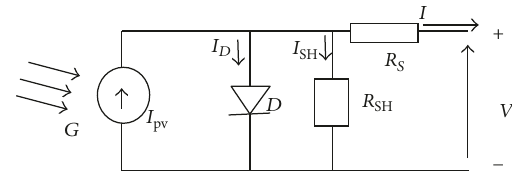
Figure 3: Single diode model of a solar cell.